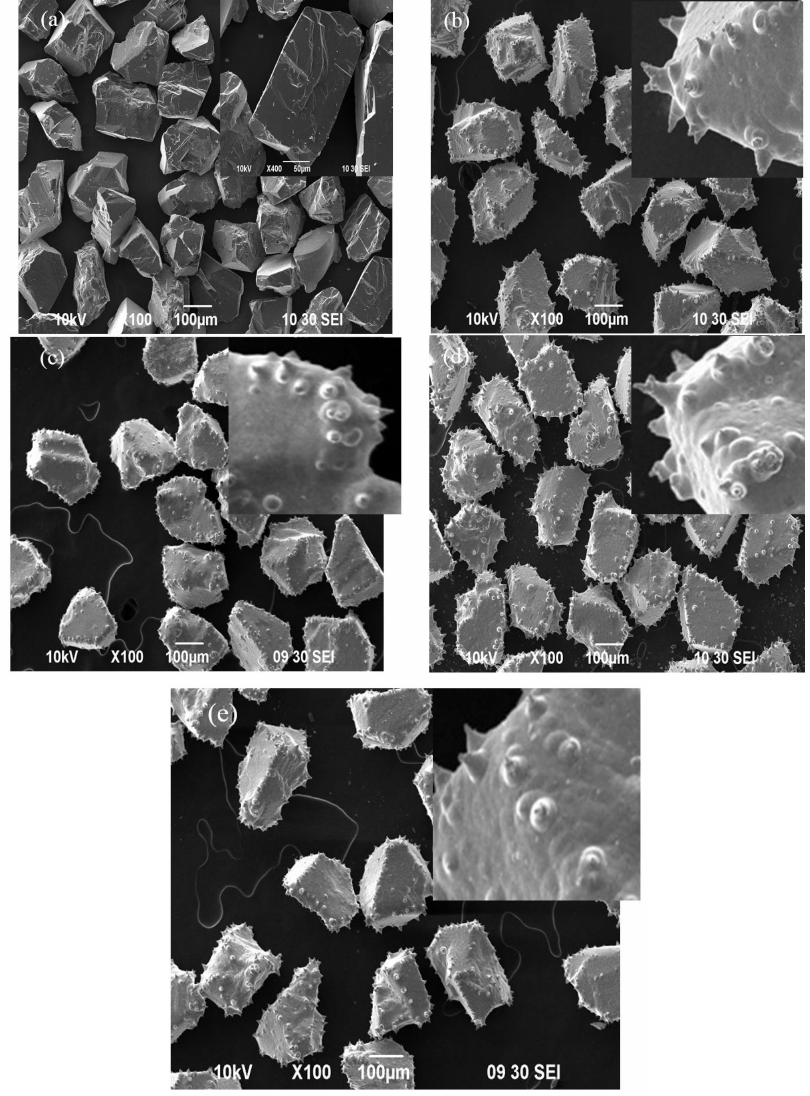
Figure 1. The SEM images of: ( a ) raw cBN grains; ( b ) S1; ( c ) S2; ( d ) S3; and ( e ) S4. Insets of a – e are their corresponding magnified images and S1, S2, S3, S4 are the samples referred to in Section 2.1